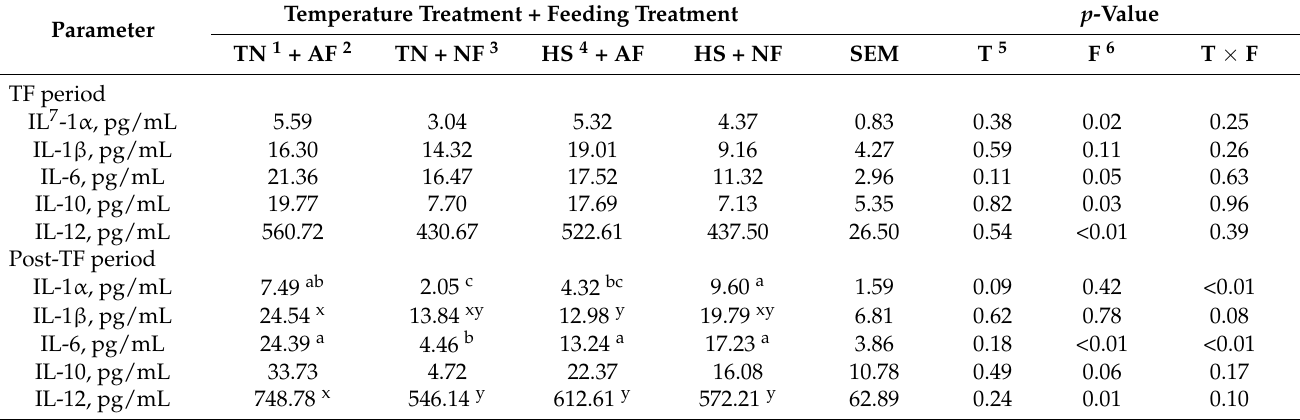
Figure 4. Effects of 24 h temperature and feeding treatment on ( A ) serum interleukin ‐ 6 and ( B ) serum interleukin ‐ 12 meas ‐ ured every 4 h in finishing pigs. Error bars indicate ± 1 SEM. Letters a and b indicate hourly differences ( p < 0.01). Hour 0 data are for descriptive purposes only.